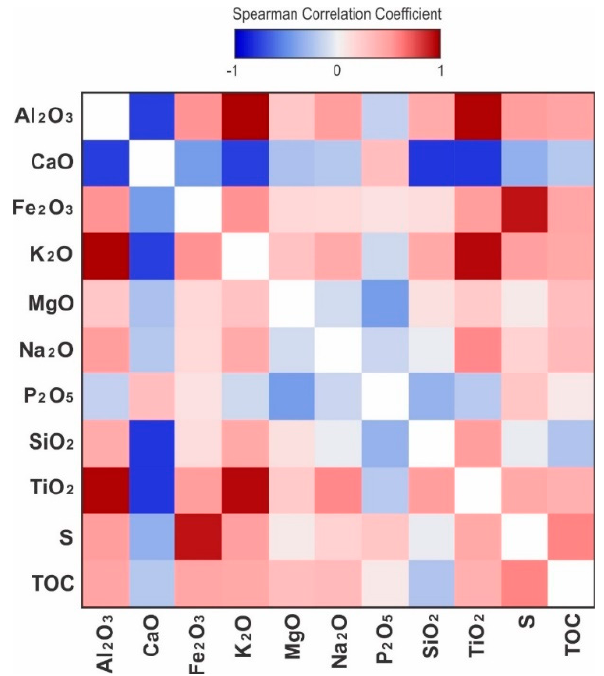
Figure 13. Heat map of the Spearman correlation coefficients between all major elements and TOC from Rock-Eval pyrolysis.